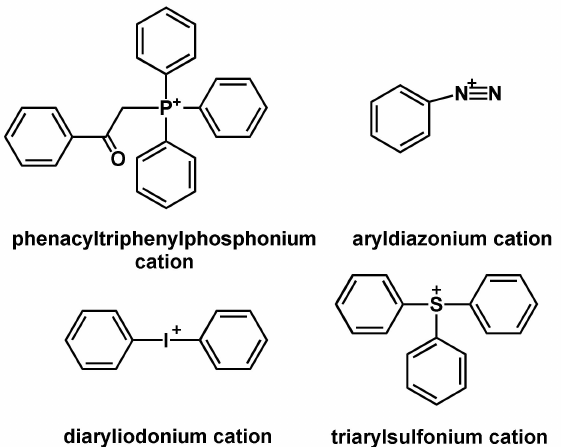
Figure 10. Chemical structures of common types of